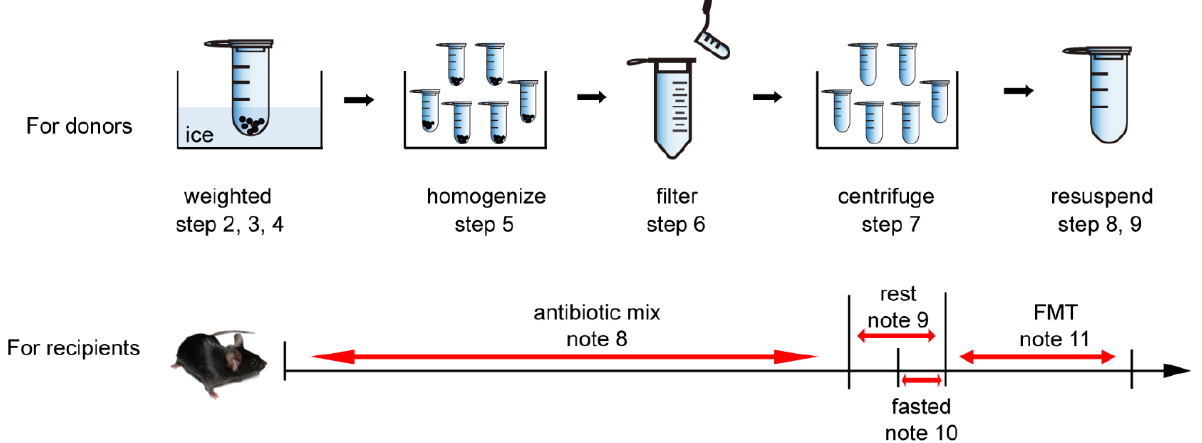
Figure 1. Schematic overview of the models, for which setup is described in the Procedure Section.